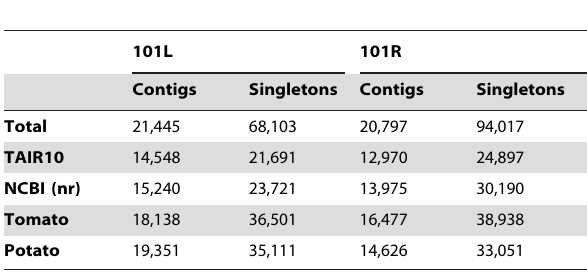
Table 2. Annotation details of 101L and 101R transcriptomes using various